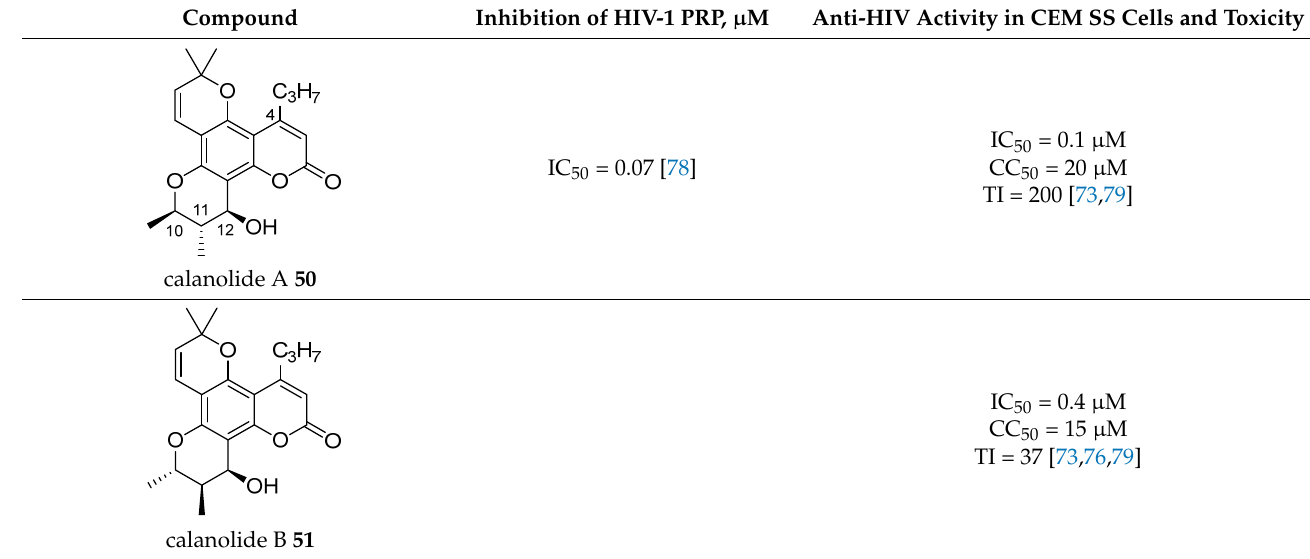
Figure 9. Linear pyranocoumarins with anti-HIV activity.